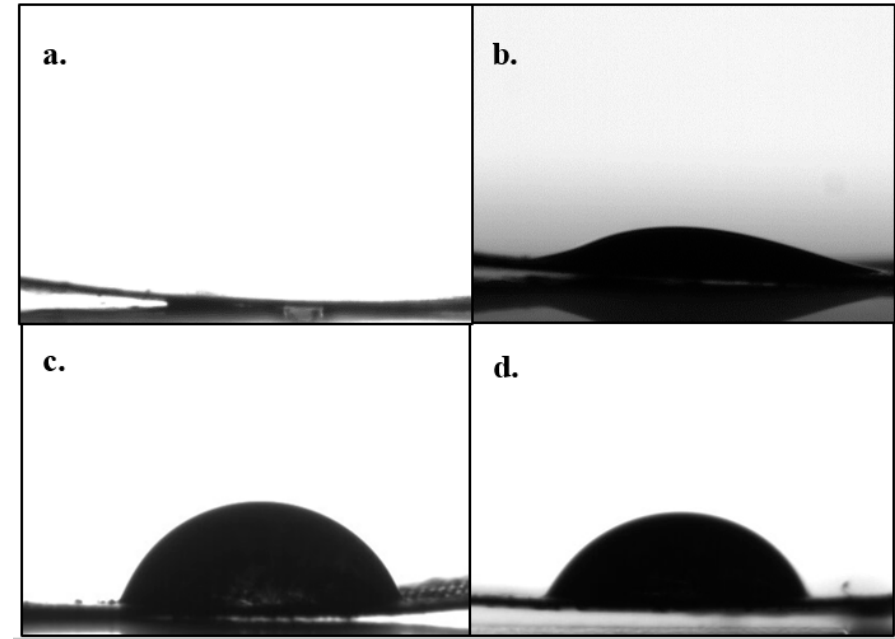
Figure 3. Water contact angle on SS-CNT VCG-treated samples, obtained through goniometry at ( a ) Day 0, ( b ) Day 6, ( c ) Day 15, and ( d ) 2 months after treatment.